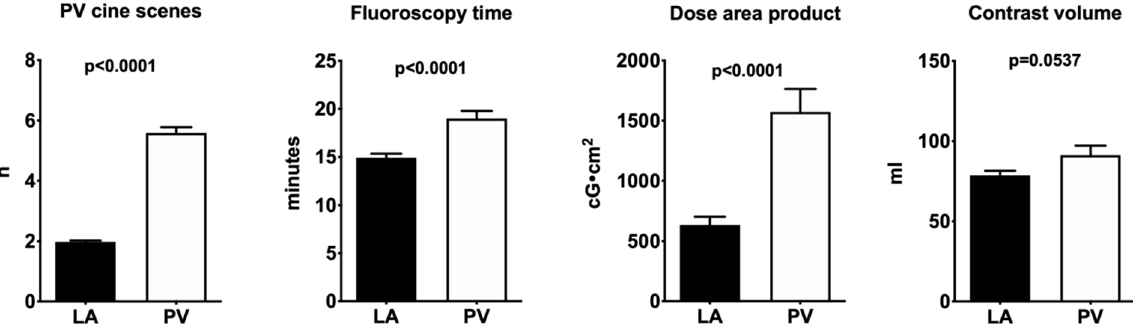
Figure 3. Graphical depiction of the results (PV: pulmonary veins; LA: left atrial angiography).